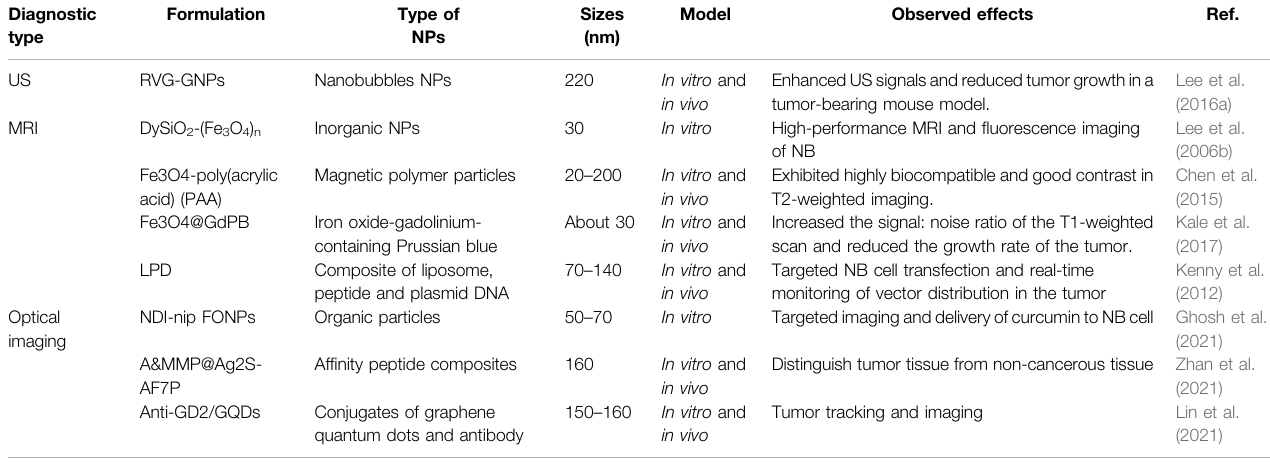
TABLE 1 | Summary of emerging nanomedicines for NB diagnostics.